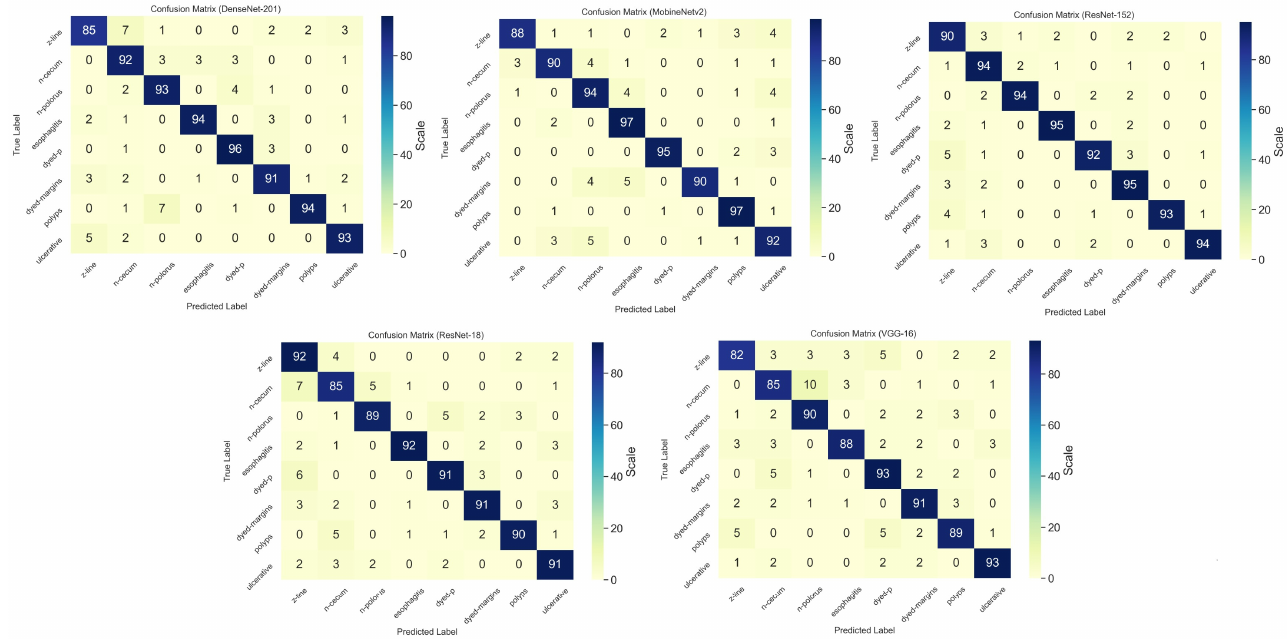
Figure 6. Confusion matrix of the CNN models with true and predicted class.